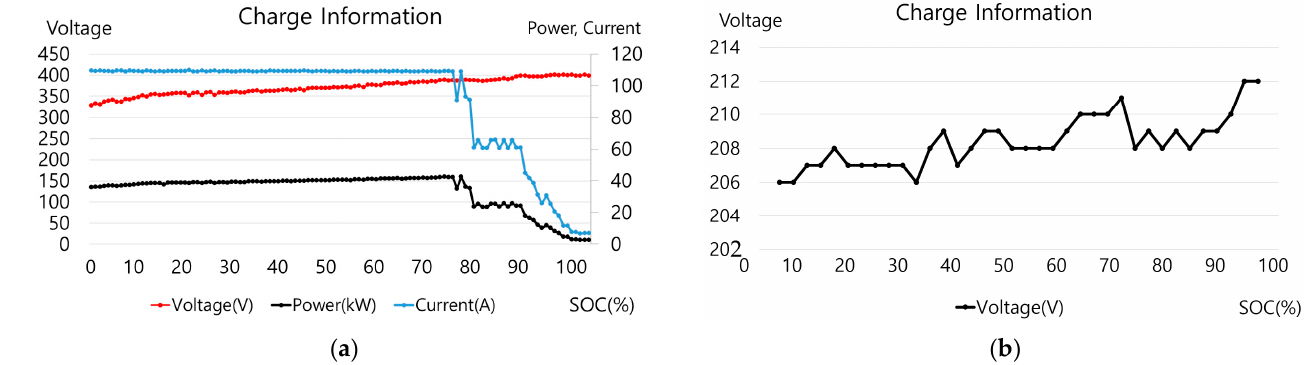
Figure 6. Stand-type charging information: ( a ) fast stand-type C (power, current, and voltage); ( b ) Figure 6. Stand‑type charging information: ( a ) fast stand‑type C (power, current, and voltage); standard stand B charging information (voltage). ( b ) standard stand B charging information